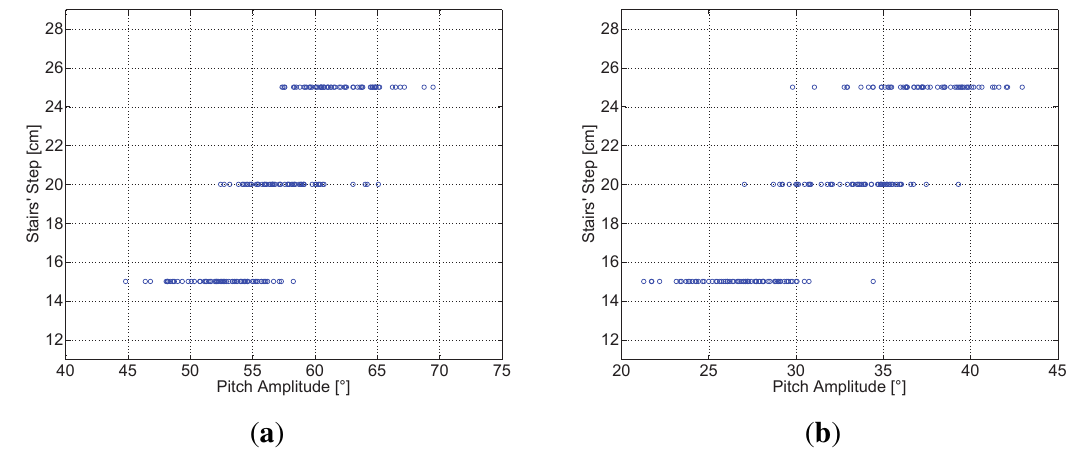
Figure 9. In this figure the points represent the steps recorded when the volunteer was walking up and down stairs on the adjustable wooden structure built for this